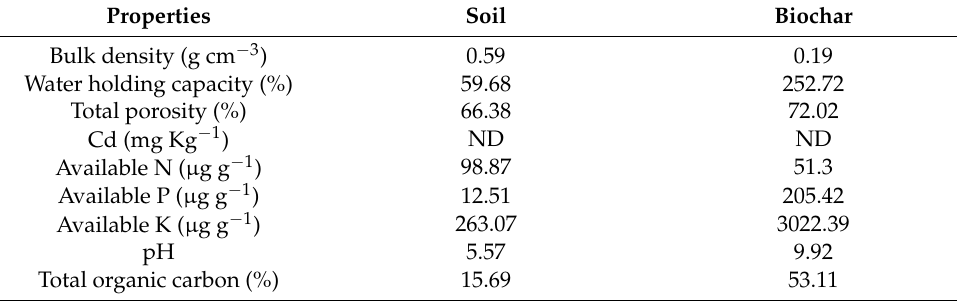
Table 1. Selected properties of soil and